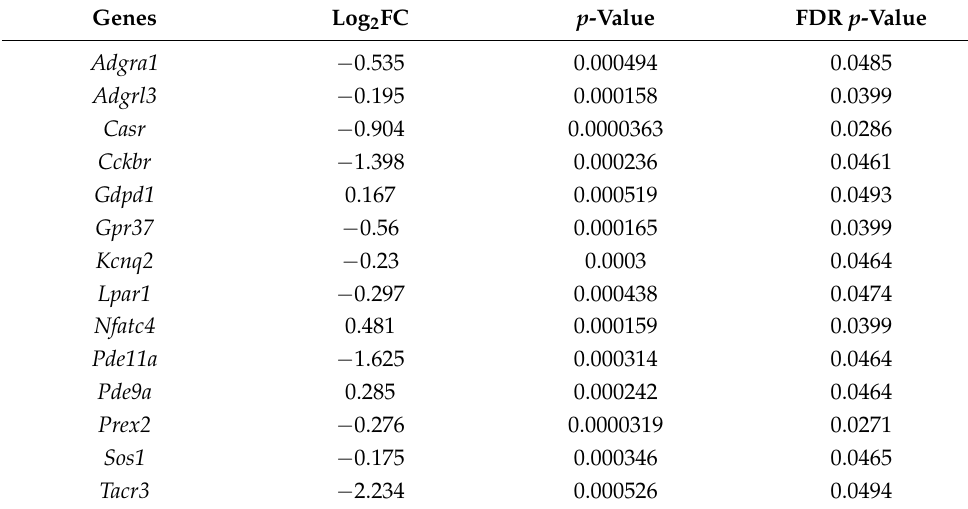
Table 3. G-protein-coupled receptor signaling genes in Homo PKC γ -A24E.